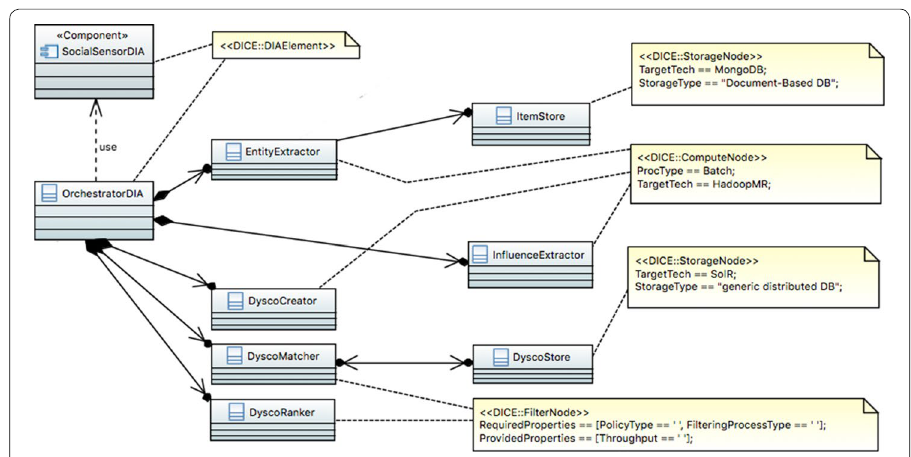
Fig. 9 Industrial case-study, a refactored